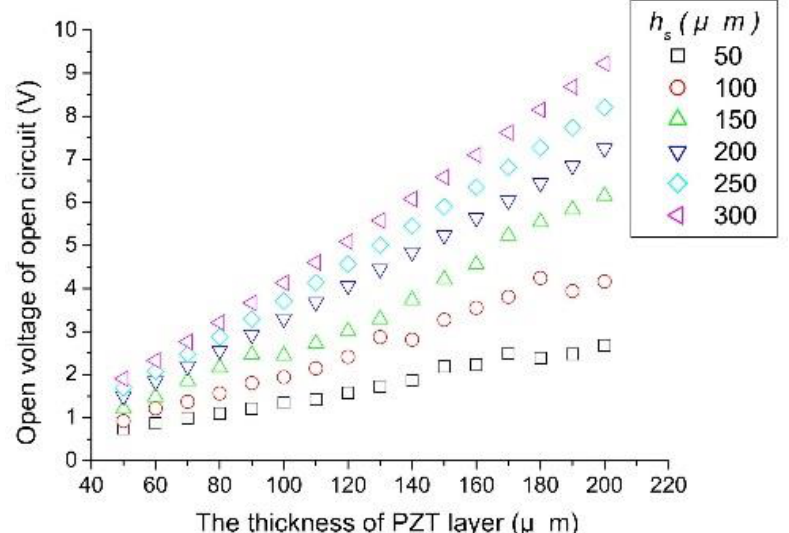
Figure 7. The analytic result for the thickness of the PZT layer vs. output voltage in an open circuit.